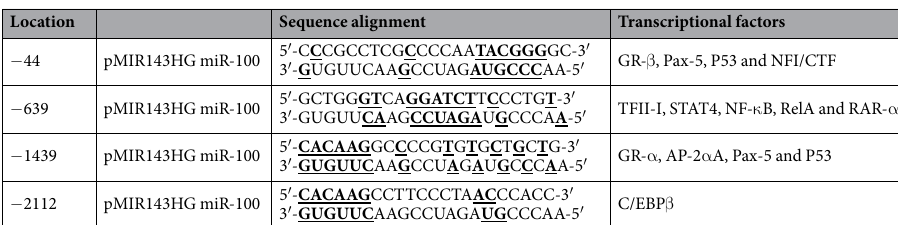
Table 3. Position and nucleotide sequences of overlapping regions between putative miR-100 target sites and transcriptional motifs on the MIR143HG promoter region. The promoter position of the nucleotide with respect to the transcription start site (defined as position 0) that is aligned to the 3 ′ end of each putative miR- 100 binding site in MIR143HG promoter region is indicated under the “Location” column. Underlined bolded letters indicate the complementary sequences for putative binding between the microRNA seed region and transcription factor motifs on the MIR143HG